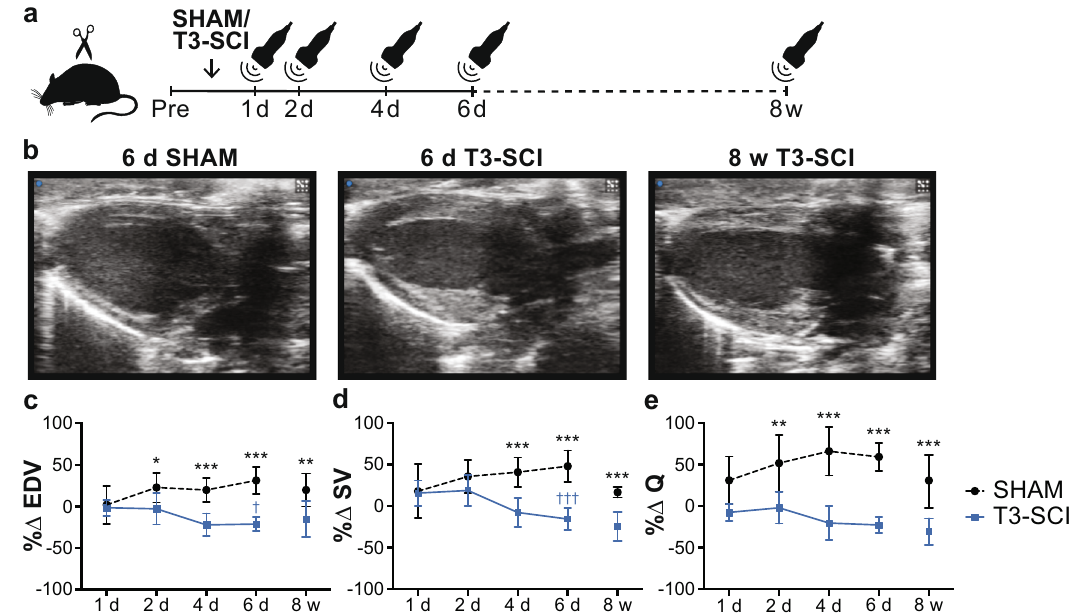
Fig. 3 Temporal progression of echocardiography-derived functional and volumetric outcomes in rats with T3 complete transection SCI (T3-SCI). a Male Wistar rats (10 – 11 wks of age) underwent either SHAM or T3-SCI. Echocardiography was performed longitudinally in an acute group at pre-surgery, 1 day, 2 days, 4 days, and 6 days post SCI/SHAM surgery, and in a chronic group at pre-SCI/SHAM and at 8 weeks post SCI/SHAM to ensure appropriate age-matching (under iso fl urane anesthesia). b Representative parasternal long-axis images of SHAM (6 days post-SHAM) and T3-SCI rats (6 days and 8 weeks post SCI) at end-diastole at identical scaling. c Percent change (% Δ ) in EDV ( n = 6 – 8/group), d SV ( n = 6 – 8/group), and e cardiac output (Q; n = 6 – 8/group) were signi fi cantly reduced acutely and chronically post T3-SCI vs. post-SHAM and compared to day 1 post-injury. Data are presented as mean ± SD. Acute % Δ data ( n = 6 – 8/group) were analyzed using a two-way repeated-measures ANOVA (factors: time and group) with Bonferroni corrected post hoc pairwise comparisons (between and within groups). Chronic % Δ data ( n = 6 – 10/group) was analyzed using a two-sample t -test. Between-group comparison: * p < 0.05, ** p < 0.01 and *** p < 0.001. Within-group comparison to 1-day post SCI/SHAM: † p < 0.05 and ††† p < 0.001. See Supplementary Data 2, 3 for detailed statistics. Source data are provided for all variables shown in this fi gure in the source data fi